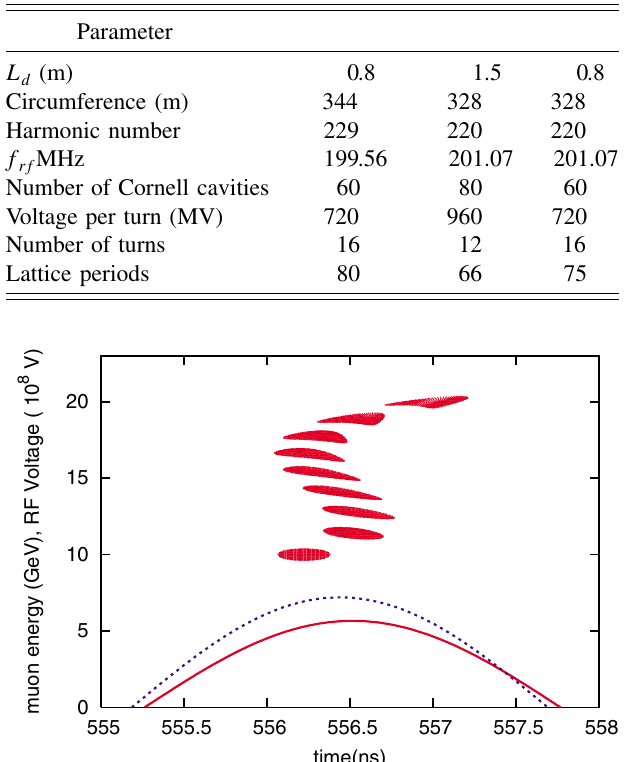
(cid:1) 0 : 8 m and d